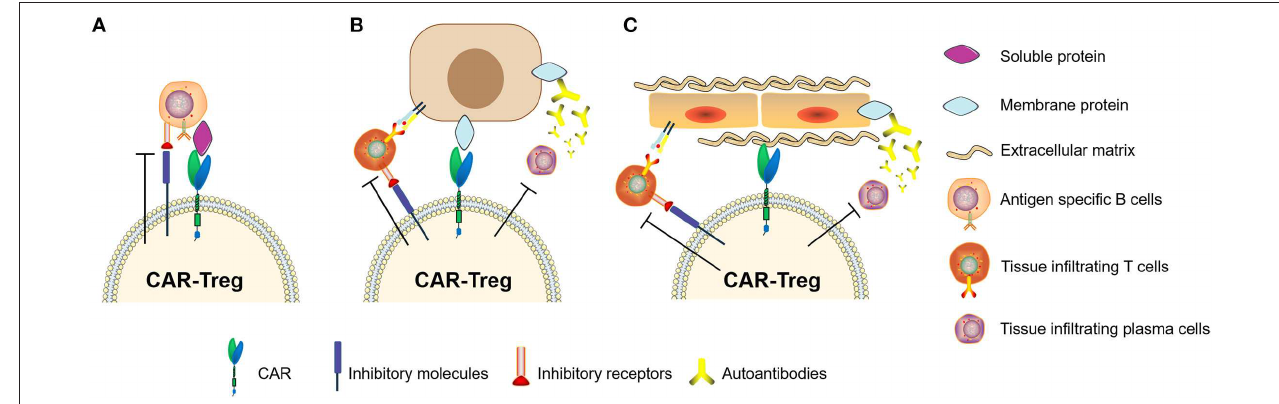
FIGURE 5 | Chimeric antigen receptor regulatory T cells (CAR-Tregs) can target different types of antigens. (A) CAR-Tregs targeting soluble proteins, (B) cell membrane proteins, and inhibiting autoimmune B cells or/and T cells. (C) We hypothesized that CAR-Tregs could also target structural proteins to achieve tissue-specific inhibition.